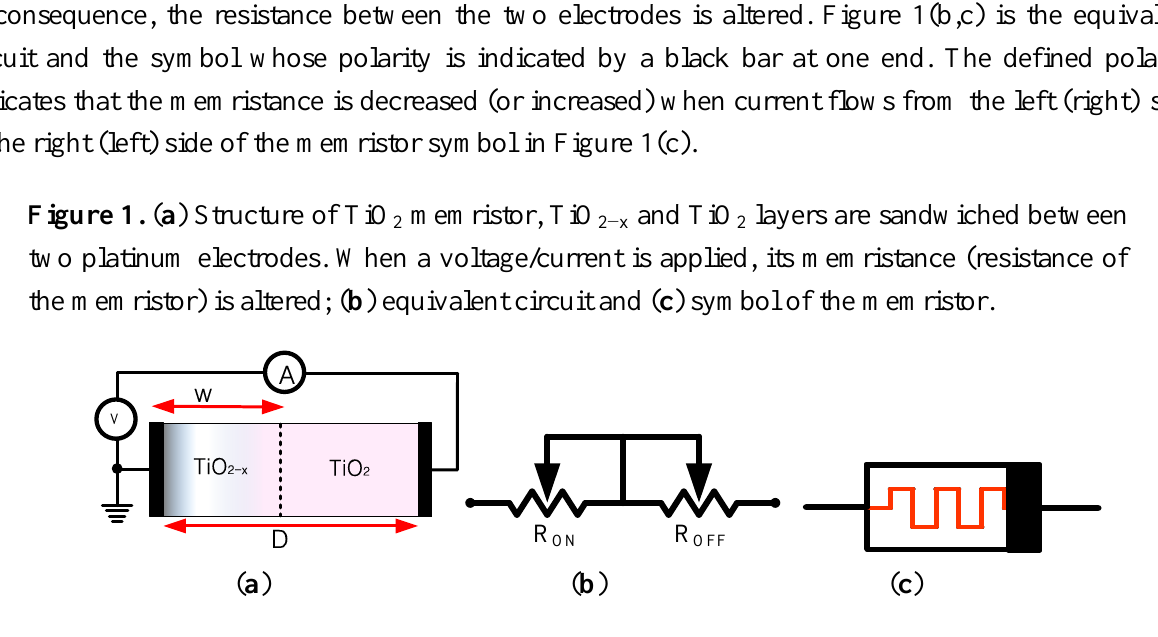
Figure 1. ( a ) Structure of TiO